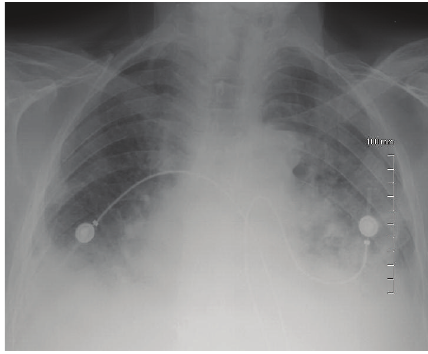
Figure 2: CXR done on 2nd day shows pulmonary edema, car- diomegaly, and bilateral pleural effusions.